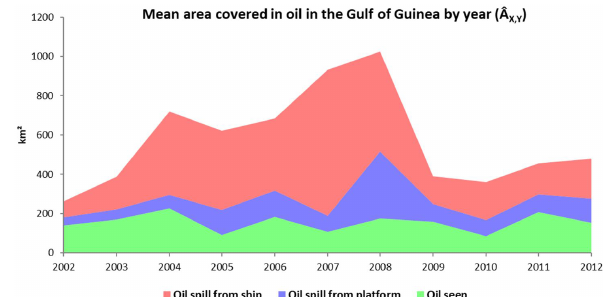
Figure 15. Mean area covered in oil in the Gulf of Guinea by year (Â X,Y